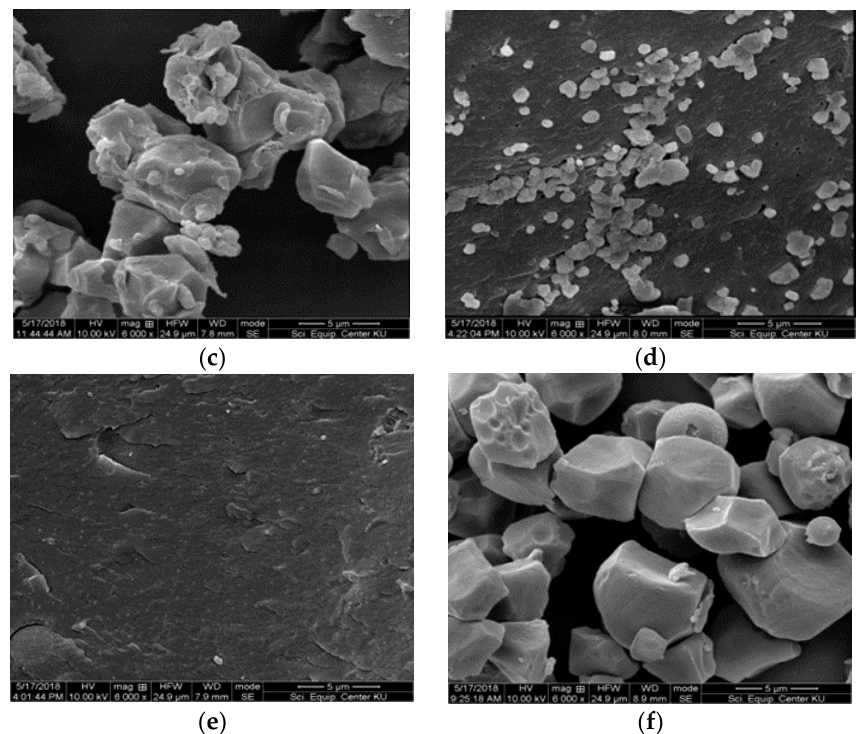
Figure 4. Morphology of starch as measured by scanning electron microscopy at 6000X. ( a ) Rice flour. ( b ) Native rice starch. ( c ) Starch treated with 2 N HCl. ( d ) Starch treated with 2 N HCl and autoclaved. ( e ) Native rice starch: autoclaved. ( f ) Native rice starch: freeze thawed.